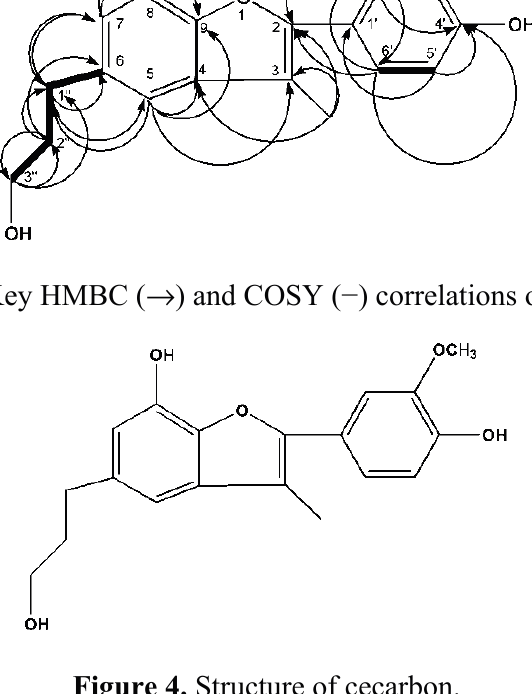
Figure 4. Structure of